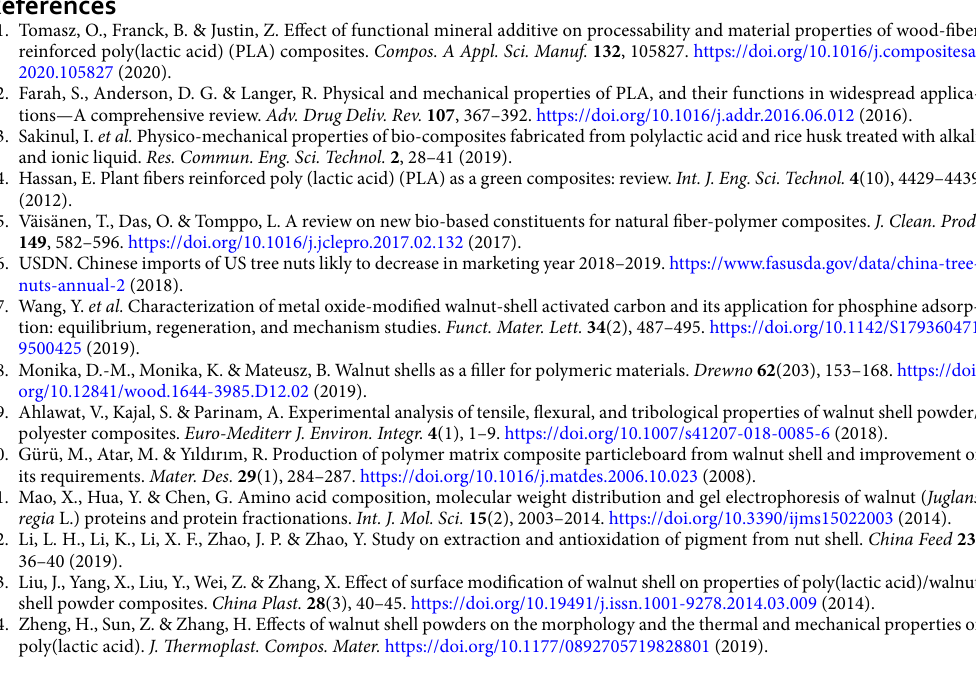
potential application prospects in structural components such as bone implants.